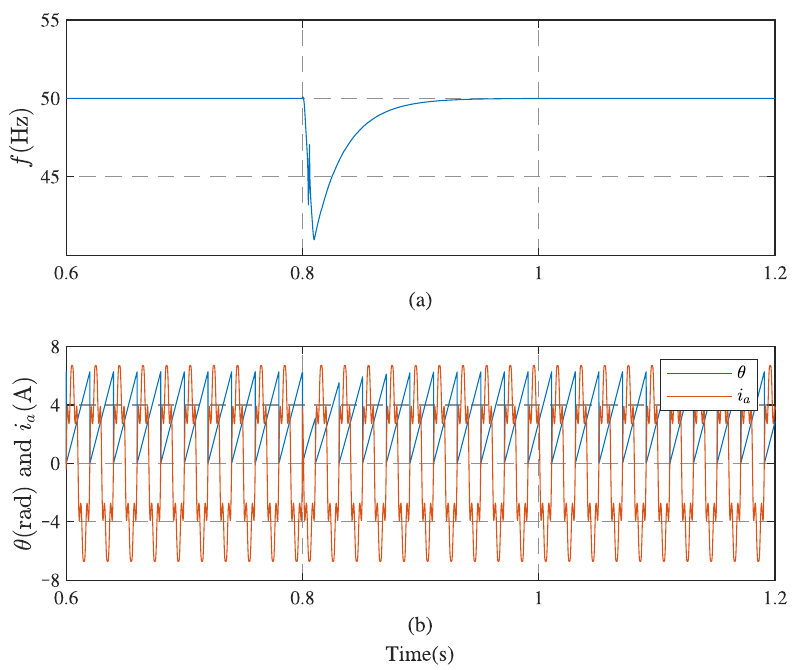
Figure 11. Simulation results with phase jump: ( a ) frequency, ( b ) comparison between θ and i a .